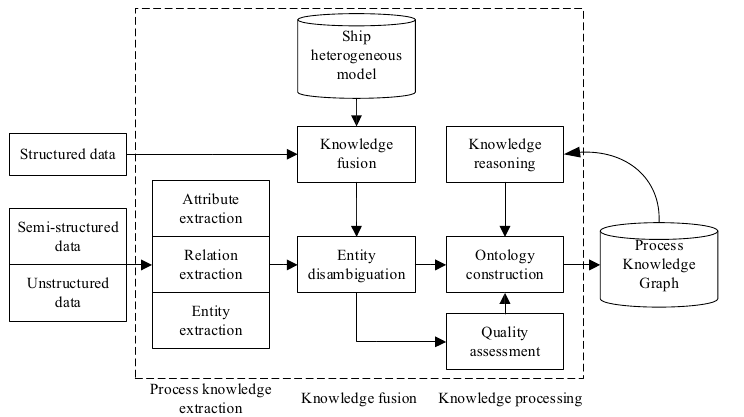
Figure 2. Process knowledge graph architecture.